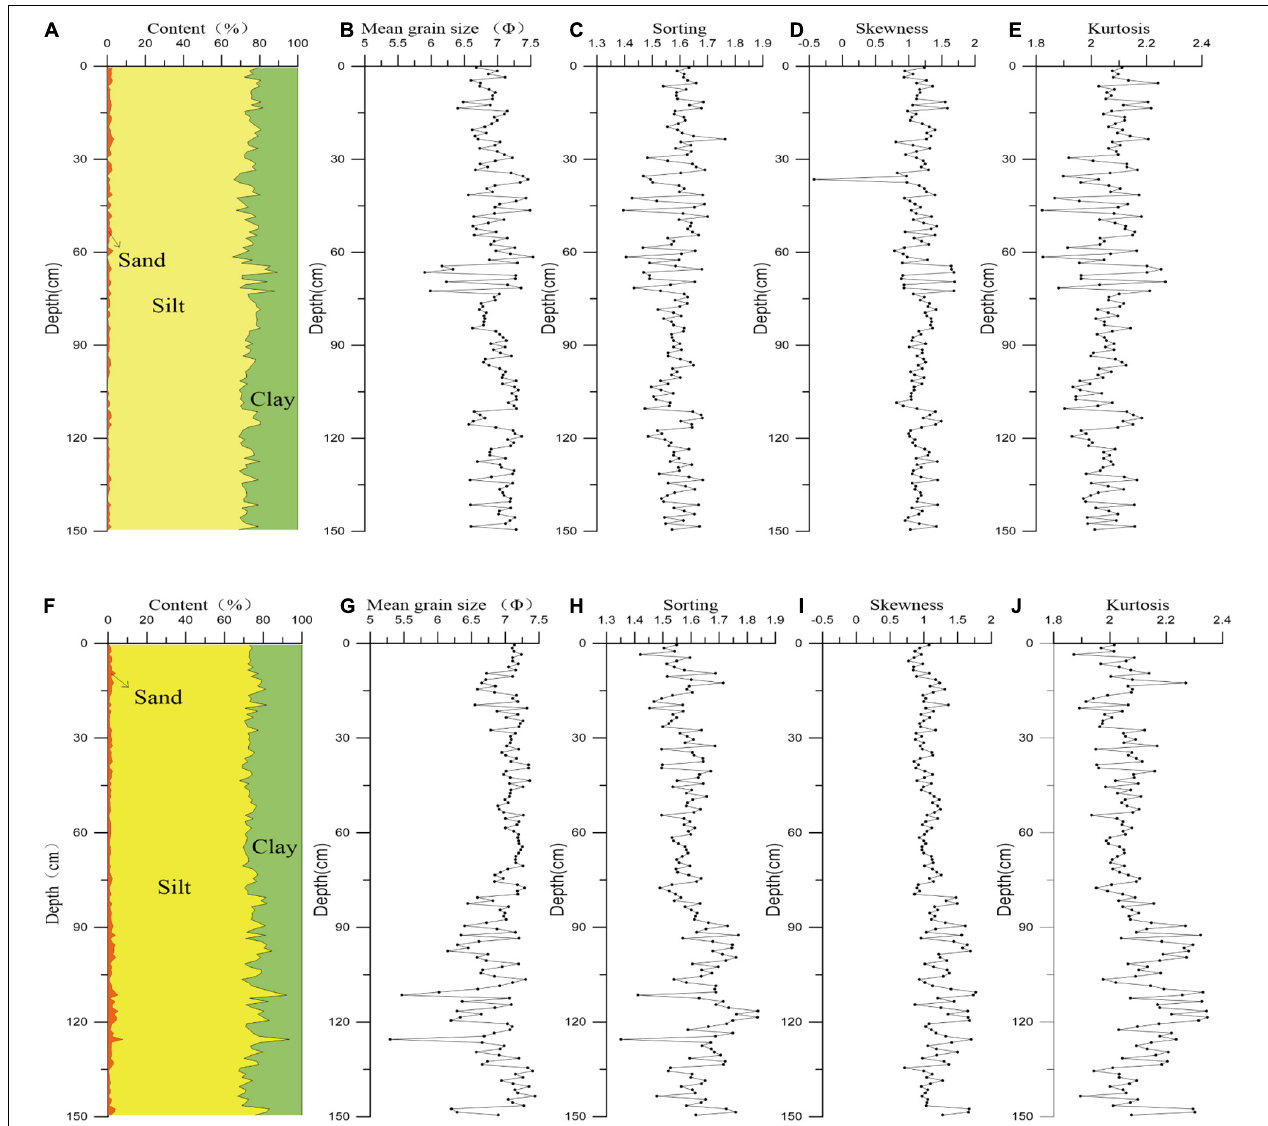
FIGURE 4 | Vertical distribution of grain size components and parameters of core Z7 (A–E) and Z8 (F–J)